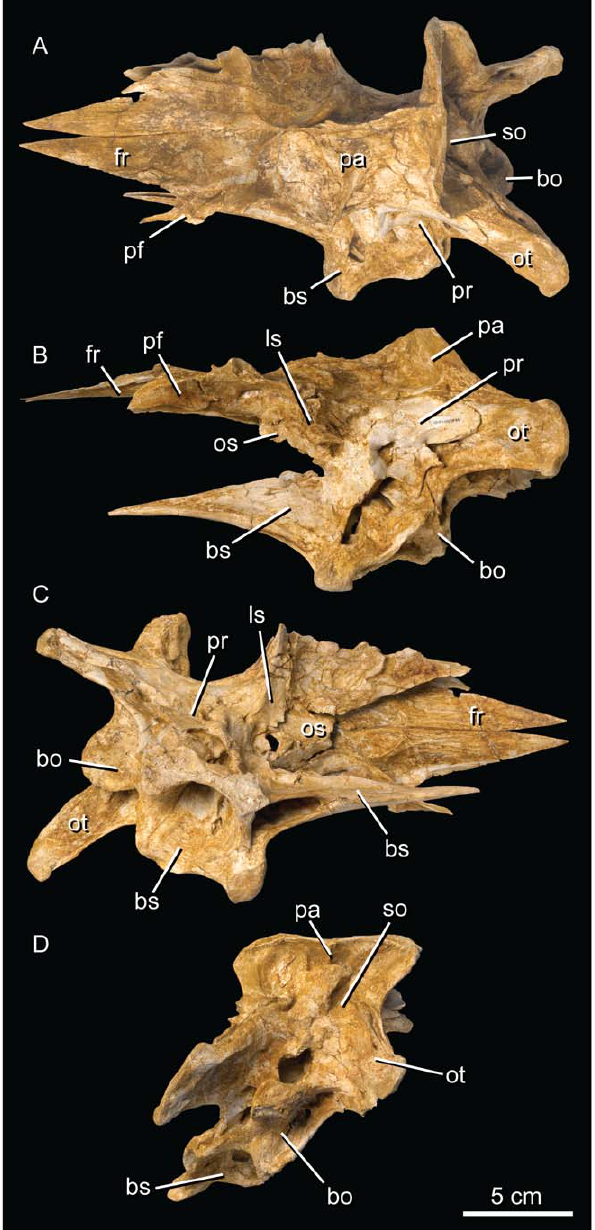
Figure 1. The braincase of Alioramus altai (IGM 100/1844) (modified from fig. 2 of [ 22 ] ). Dorsal (A), left lateral (B), ventral (C), and occipital (D) views. bo, basioccipital; bs, basisphenoid; ls, latero- sphenoid; os, orbitosphenoid; ot, otoccipital; pa, parietal; pf, prefrontal; pr, prootic; so, supraoccipital.